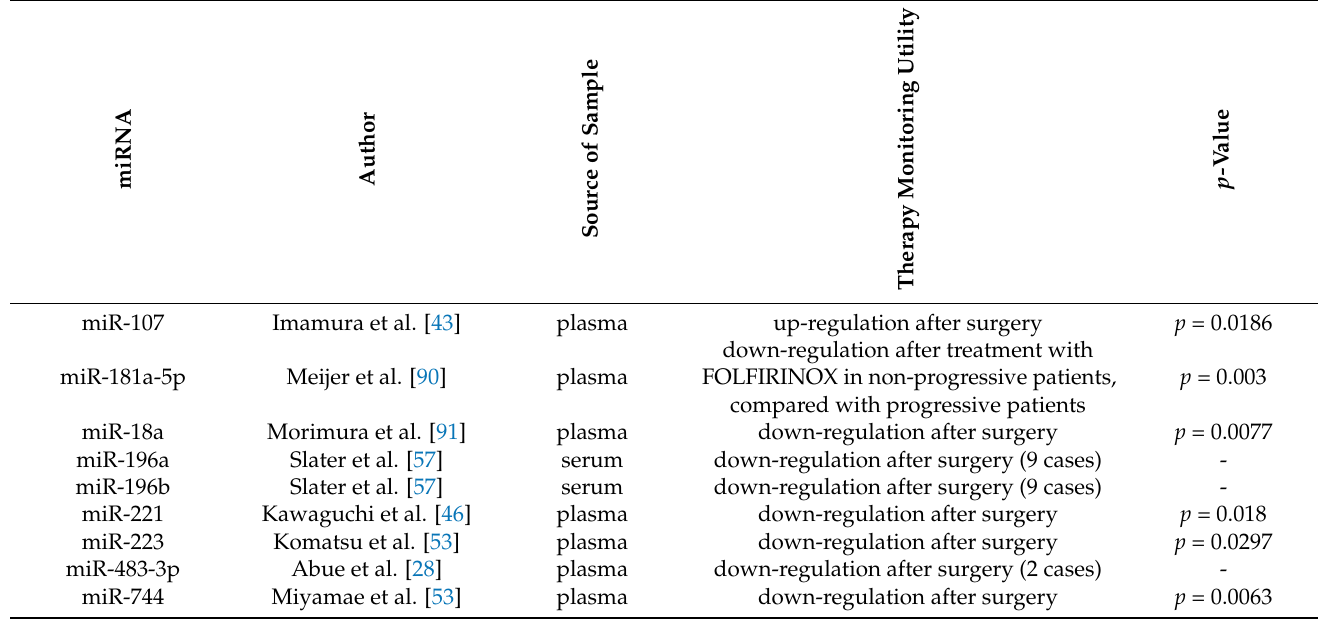
Table 2. Therapy monitoring with circulating